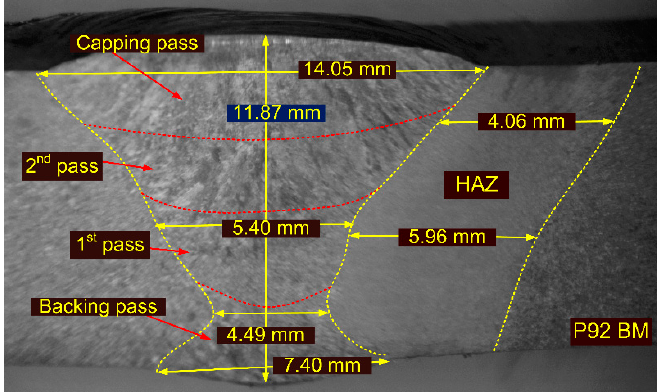
Figure 4. Macrograph of the welded joint.